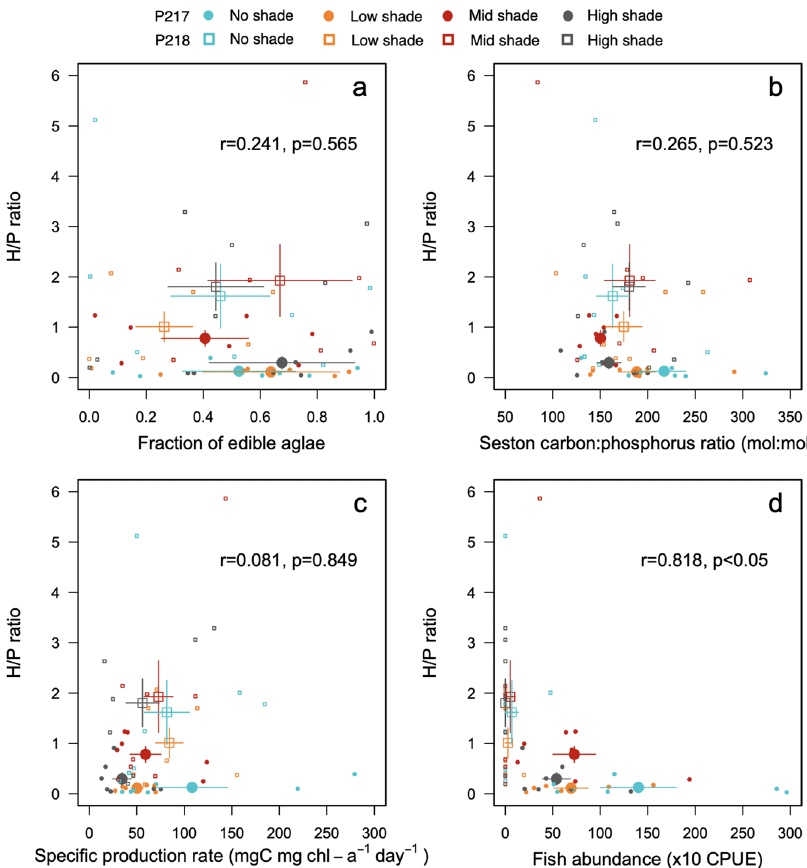
Fig. 3 Relationships between H/P mass ratio and environmental variables. H / P mass ratio plotted against edible phytoplankton fraction ( a ), seston carbon to phosphorus (C:P) ratio ( b ), speci fi c production rate ( c ), and fi sh abundance ( d ) during the experiment in no-shade (blue), low-shade (orange), mid-shade (red), and high-shade (gray) treatments in pond 217 (circles) and 218 (squares). In each panel, small symbols denote values at each sampling date, and large symbols denote the mean values among the sampling dates. Bars denote standard errors on the means ( n = 7 sampling date in each section). Correlation coef fi cients ( r ) with p values between the mean values are inserted in each panel.